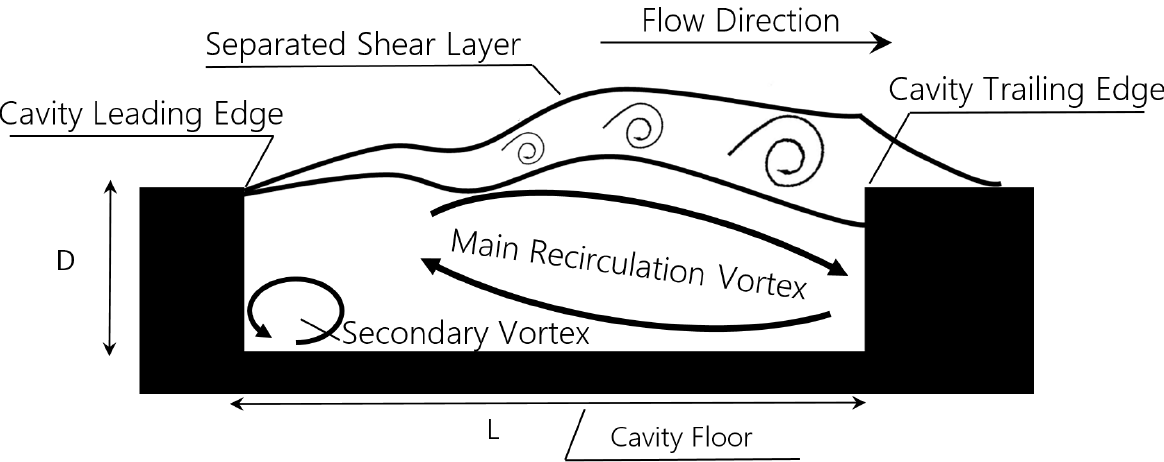
Figure 1. Typical flow topology in a shallow open